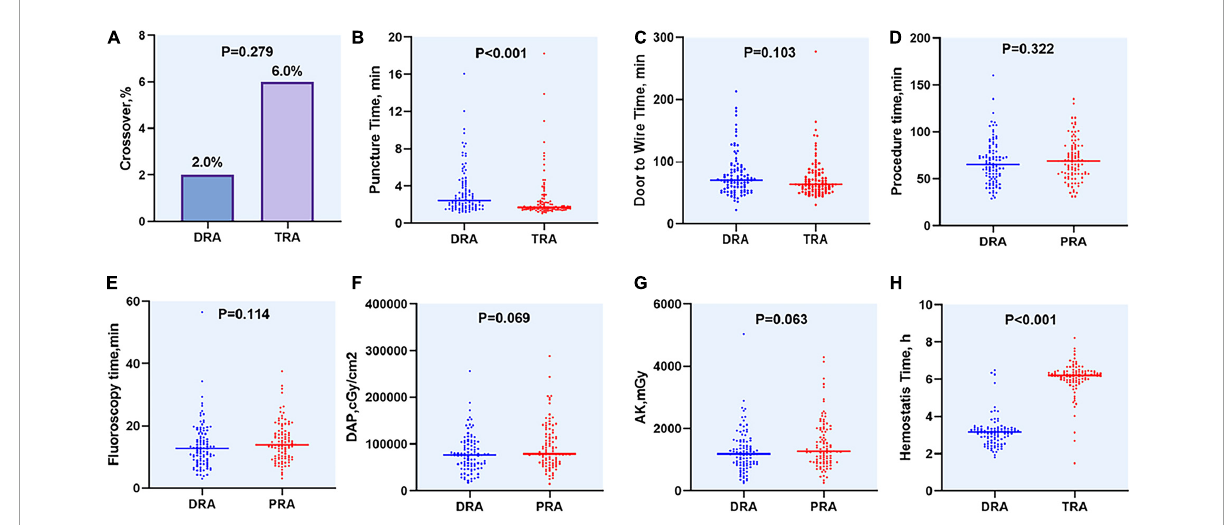
FIGURE4 Difference of access site outcomes between two groups. (A) Crossover of access site, (B) Puncture time, (C) Door to Wire time, (D) Procedure time, (E) Fluoroscopy time, (F) DAP, (G) AK, (H) Hemostasis time. DAP, dose area product; AK, air kerma.